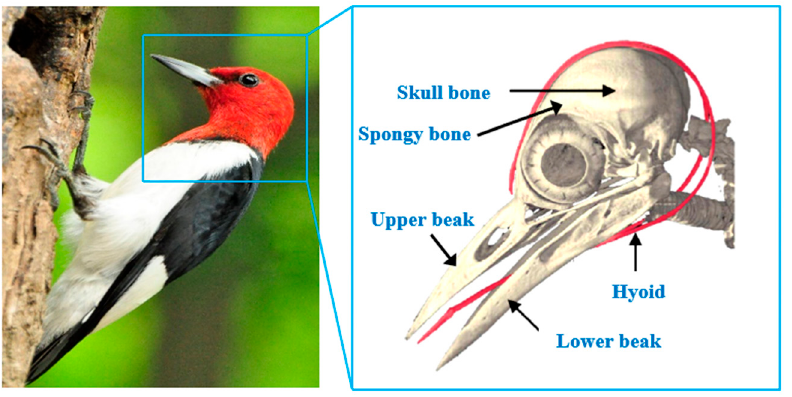
Figure 2. Woodpecker’s skull structure.